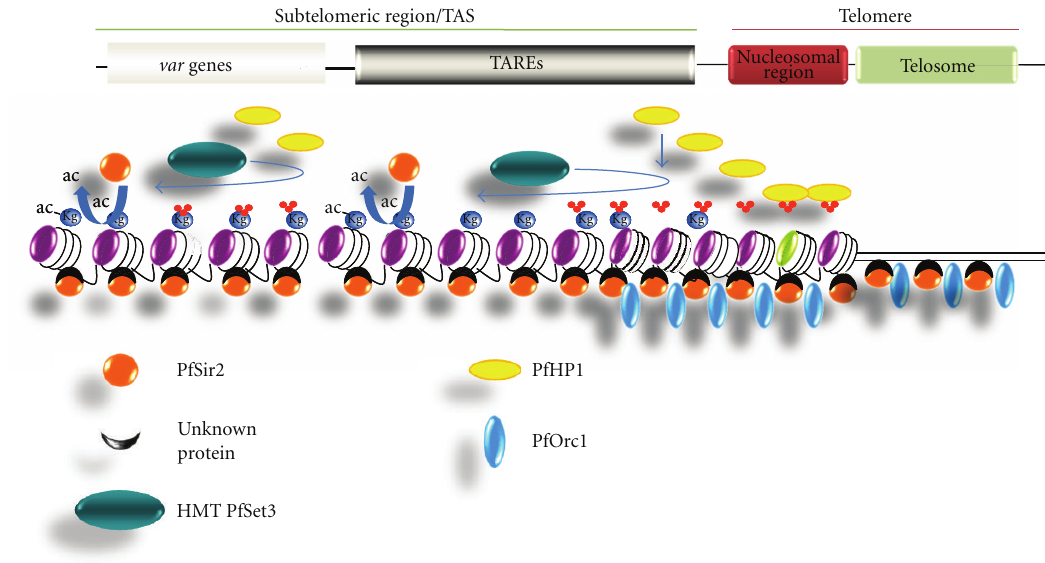
Figure 3: Hypothetical model for heterochromatin assembly at P. falciparum chromosome ends. This is a general view of the known chromatin components at P. falciparum subtelomeres. The spreading of heterochromatin along the di ff erent TAREs into adjacent coding regions probably involves PfHP1, PfSir2 and PfKMT1 in cooperation. The role of PfOrc1 in this process remains